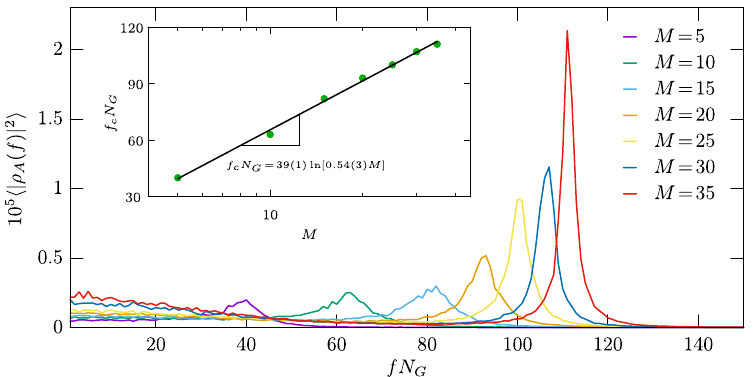
Figure 4. The power spectrum calculated from time dependence of the fraction of species A as a function of frequency that is multiplied by the number of steps. The curves are related to different values of local carrying capacity M , as indicated by the legend. All curves has a peak which position determines a characteristic frequency. The insert shows a clear logarithmic peak of this characteristic frequency as a function of M . Similar plots can be obtained for the remaining two species. This plot confirms quantitatively that the time- dependent oscillation as an accompanying feature of rotating spirals become conspicuous for high M when the environment is capable to maintain a rich